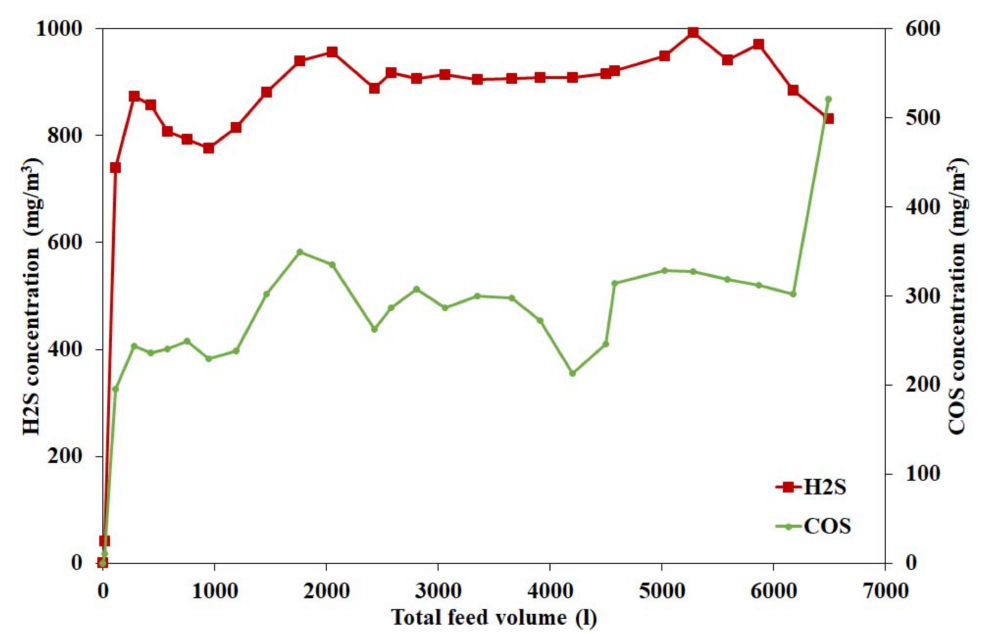
Figure 20. Catalytic tests with feed gas mixture 2 (50 mole% CO, 0.4 mole% H 2 S, balance N 2 ) at a pressure of 0.5 MPa on Co-based catalyst (9.6 wt%). Content of H 2 S and COS in the gas